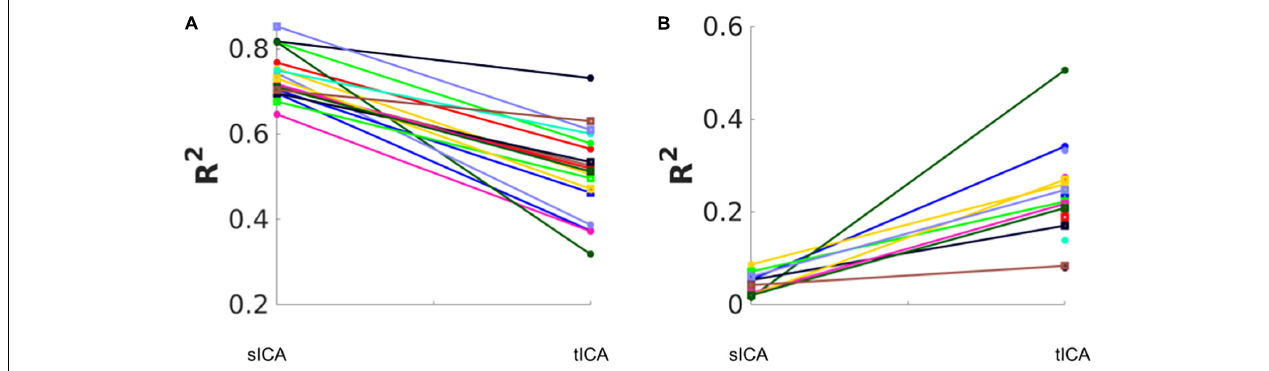
FIGURE 7 | Total variance (R 2 ) removed and retained by sICA and tICA. (A) The variance accounted for by the composite noise contributions generated from the noise-correlated ICs. (B) The variance accounted for by the composite non-noise contributions generated from the non-noise-correlated ICs. Each color represents one subject. The results show that sICA consistently removes more variance from the original signal than tICA.